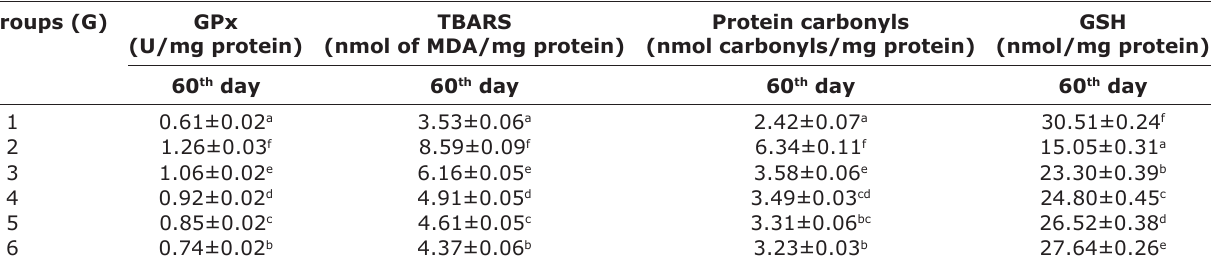
Table-3: Anti-oxidant profile in kidney homogenates in different groups of rats. Groups